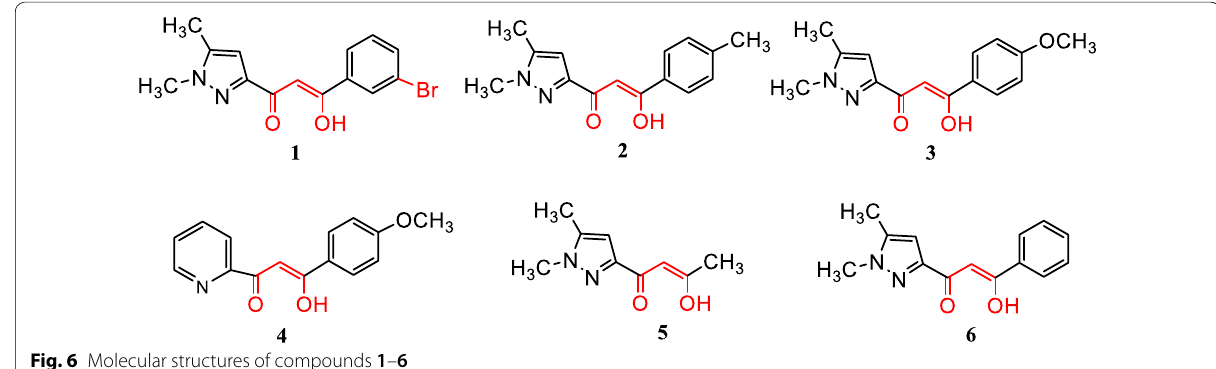
Fig. 6 Molecular structures of compounds 1 – 6